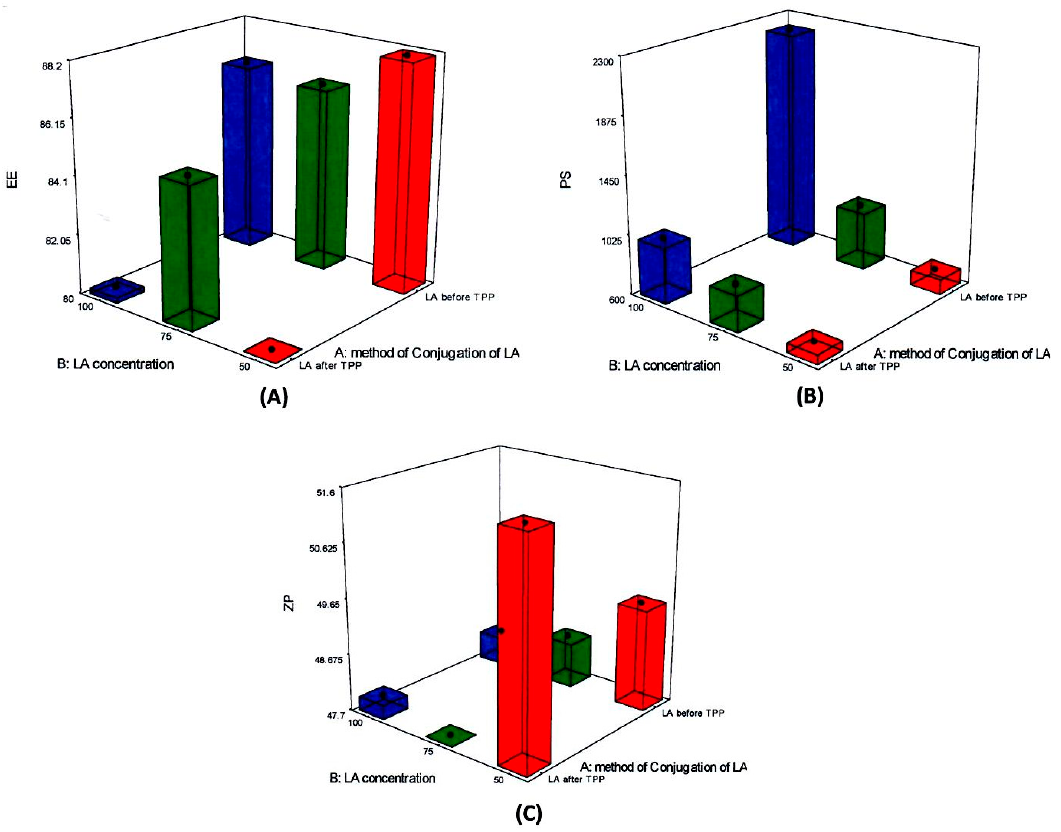
Figure 1. Response plots for the main effects of the method of addition of lactobionic acid